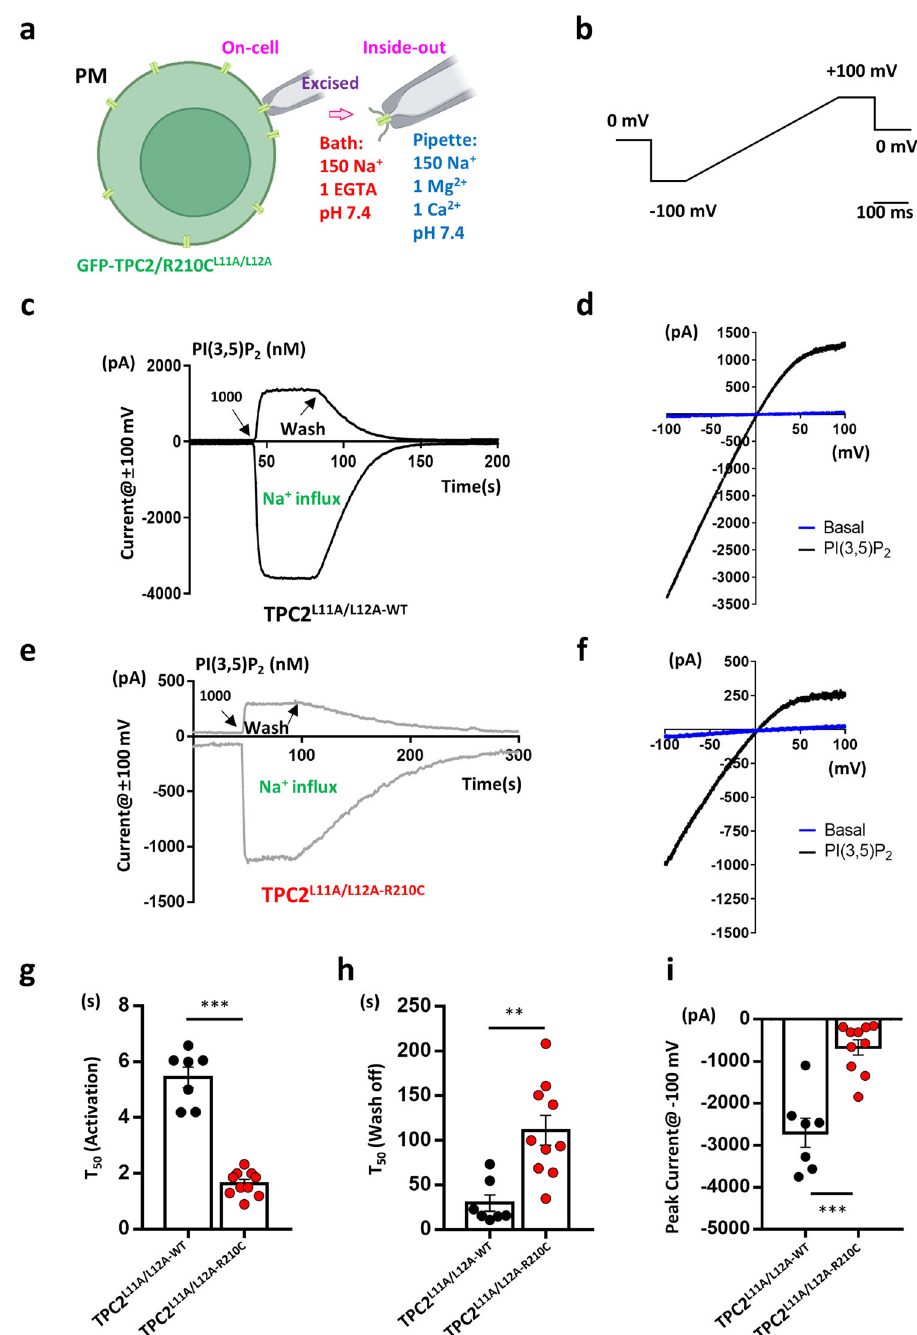
Fig.2|Inside-outrecordingsofplasmamembrane-targetedTPC2showaltered kinetics of TPC2 R210C variant in response to PI(3,5)P 2 . a A cartoon depicting the plasmamembrane(PM)localizationoftheTPC2mutantatthedi-leucinemotif(L11 and L12 at the N-terminus), TPC2 L11A/L112A , and the patch-clamp con fi gurations using forresultsshowninFigs.2 – 4.Themaincationcompositionsofthepipettesolution (in blue) and the bath solution (in red) are listed. Figures 2, 3, and 4c – f show currents recorded in the inside-out period. PI(3,5)P 2 -diC8 and other phosphoino- sitides were applied through perfusion to the cytoplasmic side of the membrane. Figure4ashows currents recorded in on-cell period, followed by thatin the inside- outperiod.TheschemeisdrawnusingBioRenderwithpermission. b Voltageramp protocol used to elicit ionic currents. c Representative traces of TPC2 L11A/L12A-WT currents before and during the application of 1 µ M PI(3,5)P 2 -diC8 and after the wash-off of the agonist. The upper trace represents outward current at +100mV re fl ecting Na + ef fl ux to the extracellular (pipette) side, while the lower trace